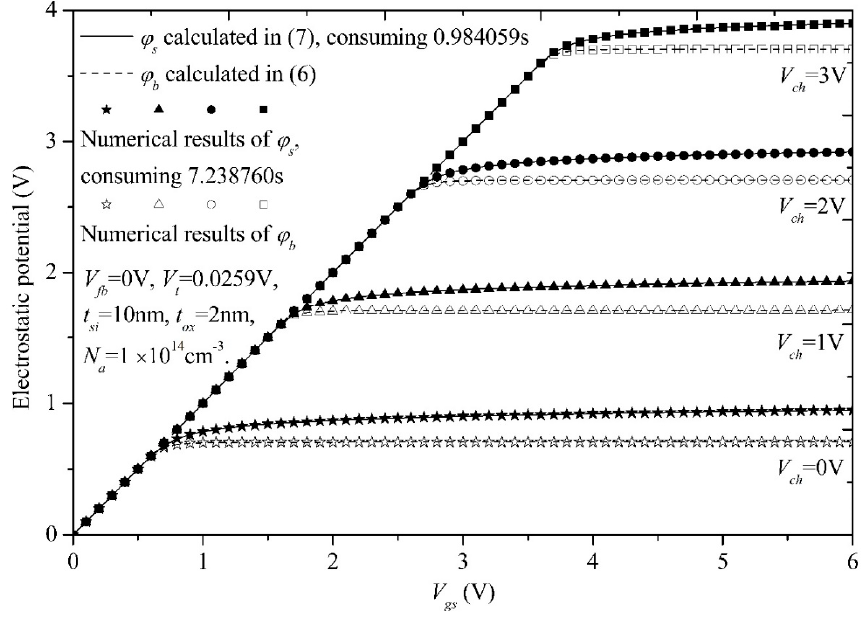
Figure 2. Comparisons between the surface potential scheme and numerical results for different V ch .